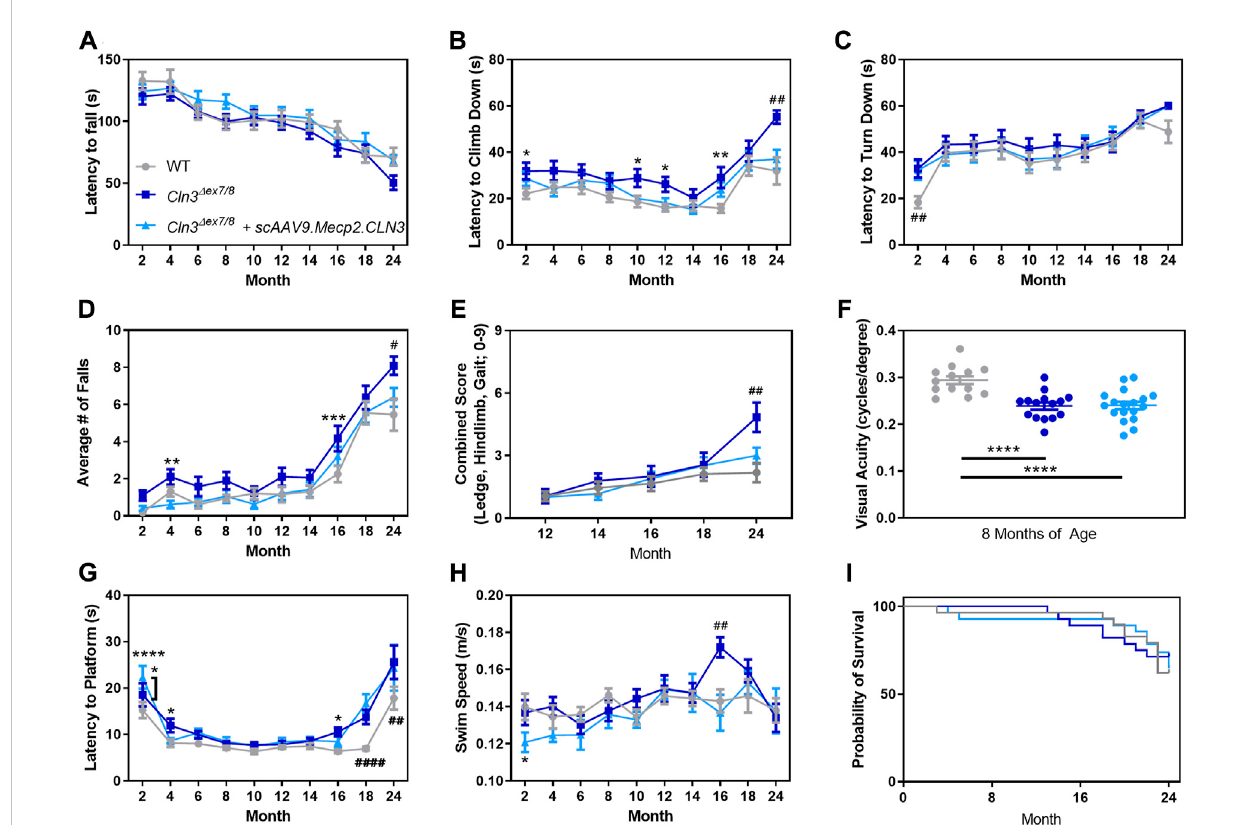
FIGURE 7 AAV9 administration prevents late stage motor de fi cits, but not memory/learning or visual de fi cits. While Cln3 Δ ex7/8 mice do not show strong behavioralde fi citsintheacceleratingrotarod (A) ,AAV9administrationpreventedmotorde fi citsat24 monthsofageinthepoleclimbdescent (B) ,fall (D) , and neurodegeneration score (E) . AAV9 administration does not prevent early motor presentations in pole climb turn (C) , visual de fi cits as measured by optokinetic tracking (F) , or memory/learning de fi cits as measured by a Morris water maze (G,H) . No survival differences were detected between the three treatment groups (I) . Two-way ANOVA, Tukey correction (A – E,G,H) , One-way ANOVA, Tukey correction (F) , and Mantel-Cox log rank. Mean ± SEM. Asterisks denote comparison to wild type unless otherwise noted. Hash signs denote comparison to all other groups. * p < 0.05, ** p < 0.01, *** p